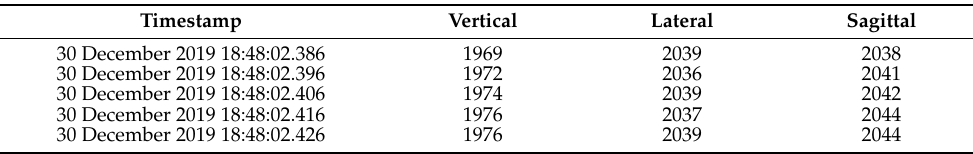
Table 2. Raw accelerometer data collected using Zephyr device.